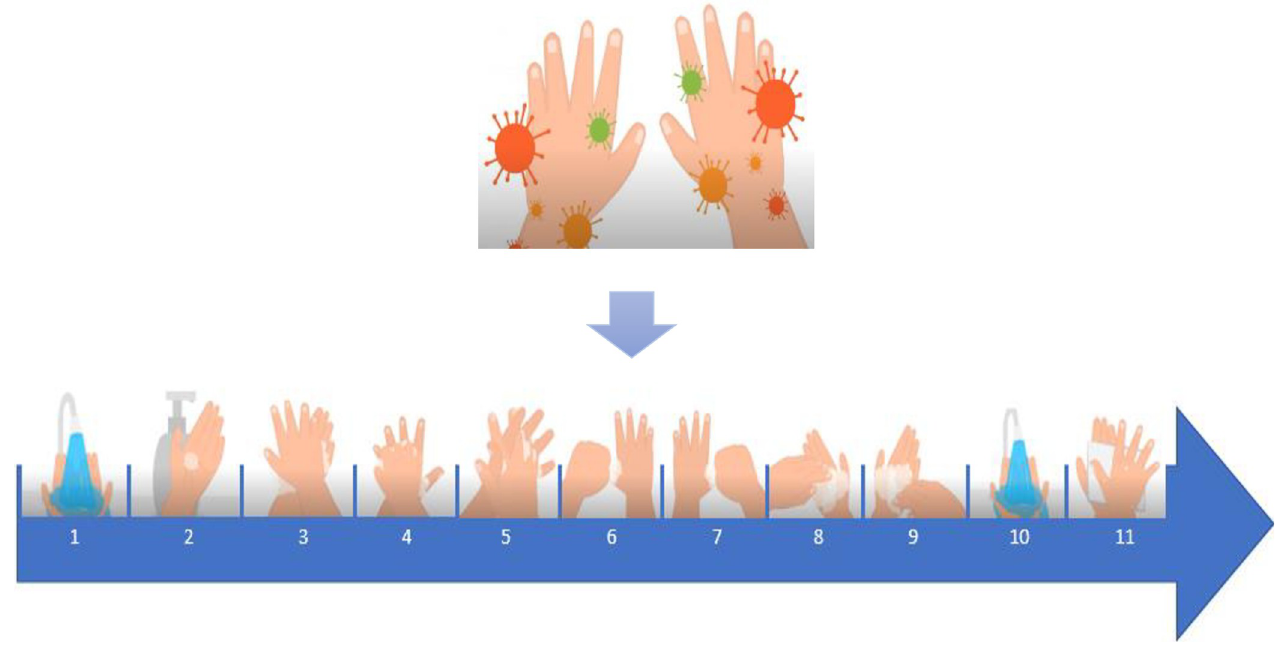
Fig 6. The “How to handwash” content of the video on the screen